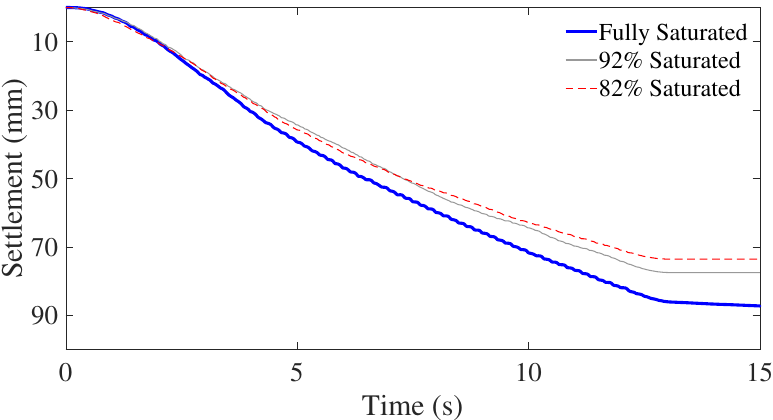
Figure 12. Settlement time histories for soil deposits with different degrees of